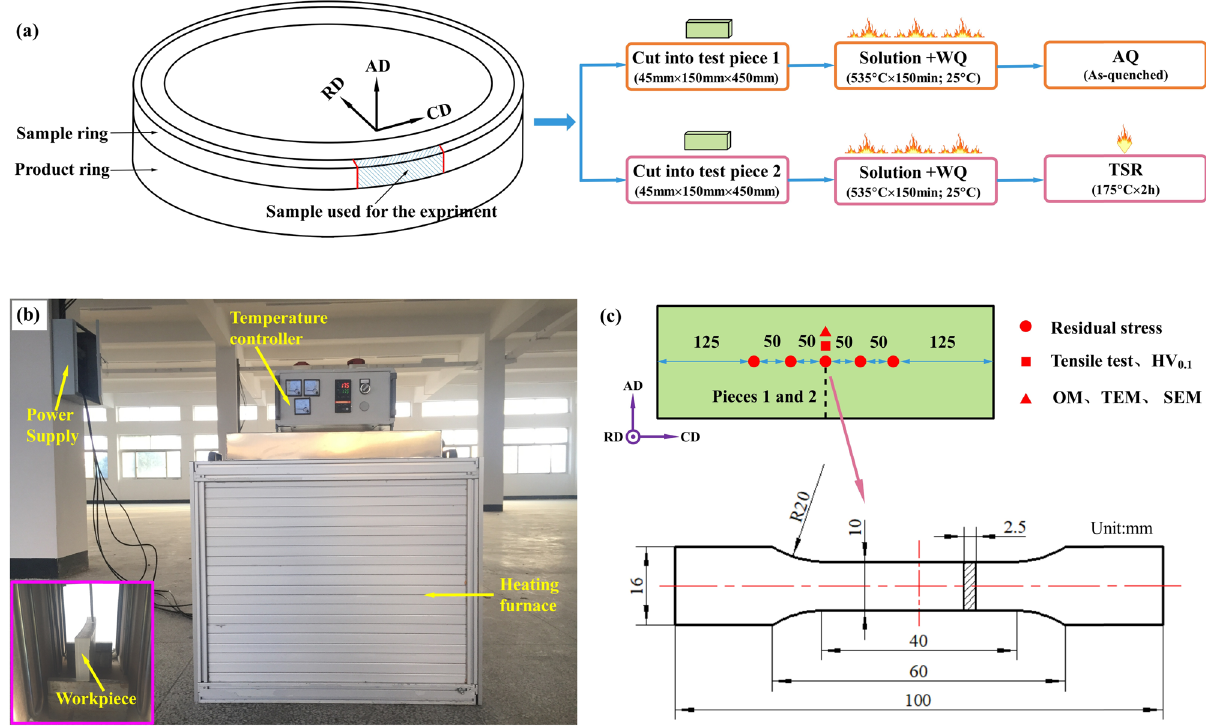
Figure 1: TSR experiments and sampling location maps: ( a ) sampling and various processing routes, ( b ) experimental equipment of TSR, and ( c ) measurement location and tensile sample maps. The dot in the direction icon indicates that RD is perpendicular to the paper surface and outward.